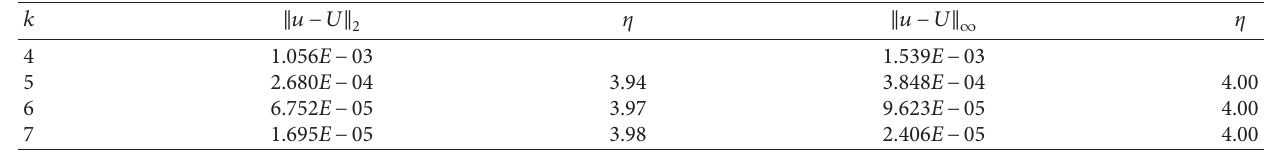
Table 3: The errors for finite difference solutions in two norms.